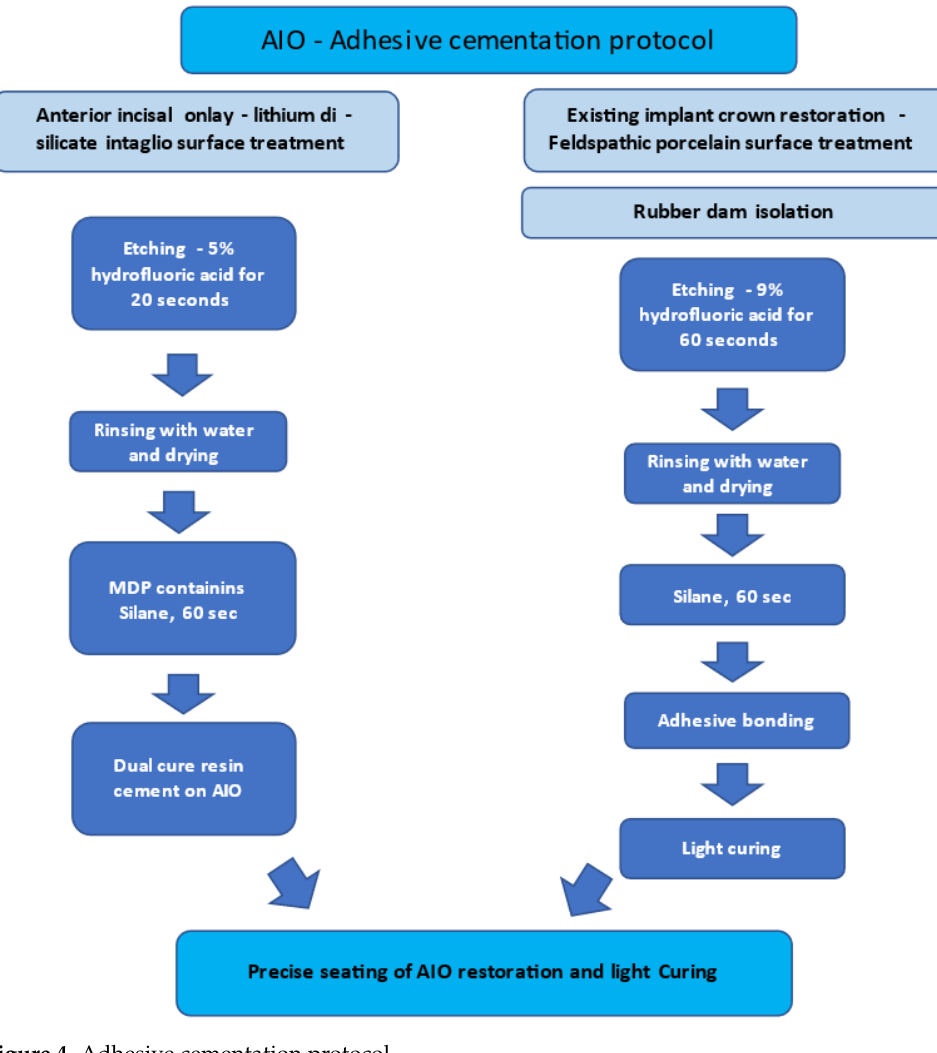
Figure 4. Adhesive cementation protocol.